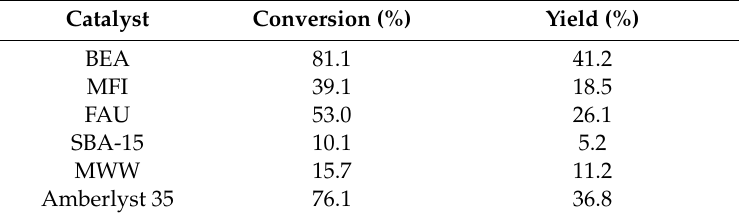
Table 2. Synthesis of isosorbide by dehydration of sorbitol on various catalysts after 5 h of process time at 200 ◦